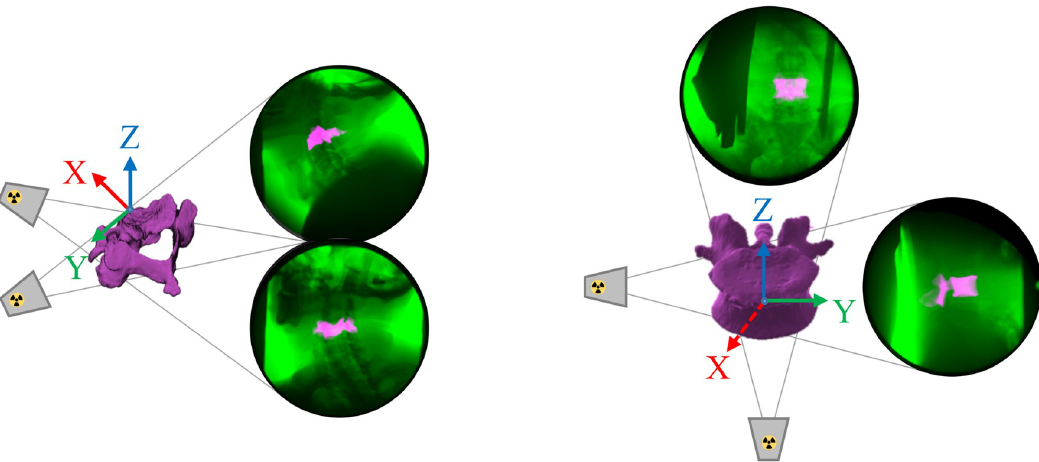
Fig 1. 2D/3D shape-matching schematic. 2D/3D shape-matching with biplane radiographic images and associated digitally reconstructed radiographs (DRR’s) for (Left) cervical spine and (Right) lumbar spine with inset C4 and L4 CT bone models and local coordinate systems.